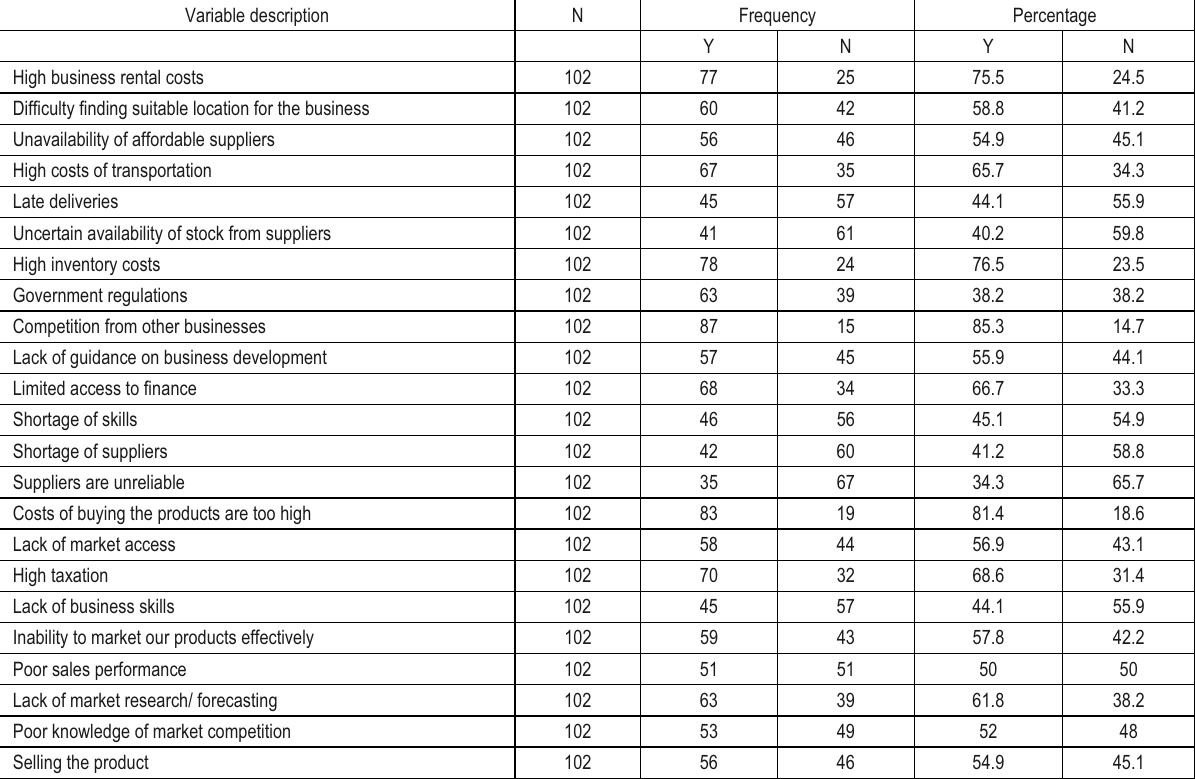
Table 1. Descriptive: frequencies and